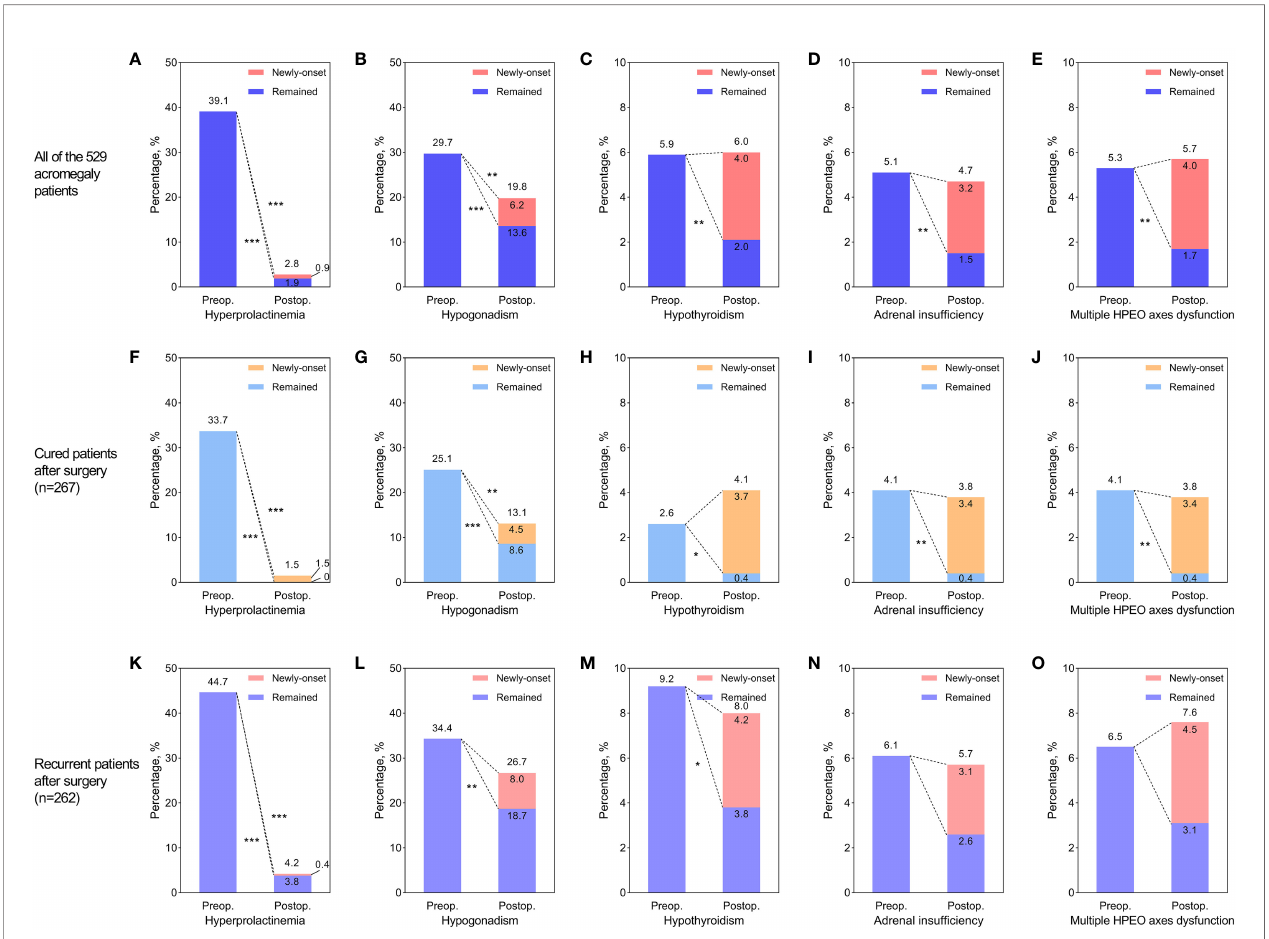
FIGURE 2 | The effect of surgery on hyperprolactinemia and hypopituitarism in all acromegaly patients (A – E) , cured patients (F – J) , and recurrent patients (K – O) . (A, F, K) Improvement of preoperative hyperprolactinemia and newly-developed postoperative hyperprolactinemia. (B, G, L) Improvement of preoperative hypogonadism and newly-developed postoperative hypogonadism. (C, H, M) Improvement of preoperative hypothyroidism and newly-developed postoperative hypothyroidism. (D, I, N) Improvement of preoperative adrenal insuf fi ciency and newly-developed postoperative adrenal insuf fi ciency. (E, J, O) Improvement of preoperative multiple hypothalamus-pituitary-end organ (HPEO) axes dysfunctions and newly-developed postoperative multiple HPEO axes dysfunctions. The stars to the lower left of the dotted lines indicated that the improvement of hyperprolactinemia or hypopituitarism after surgery was signi fi cant. The stars to the upper right of the dotted lines indicated that the differences between preoperative rates of hyperprolactinemia/hypopituitarism and postoperative rates were signi fi cant. * indicated p <0.05, ** indicated p <0.01, and *** indicated p <0.001. Preop, preoperative; Postop,